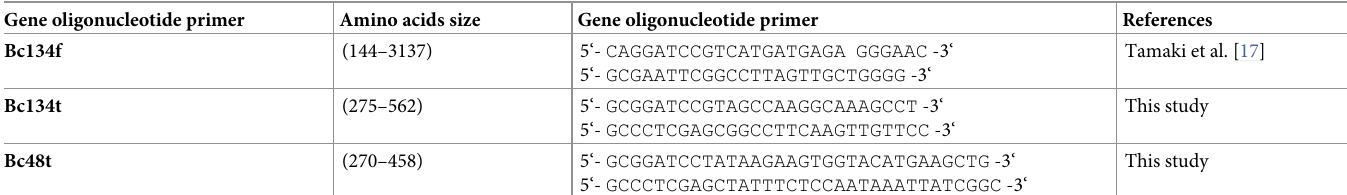
Table 1. Gene-specific primers for amplifying Bc134, Bc134t, and Bc48t. Gene oligonucleotide primer Amino acids